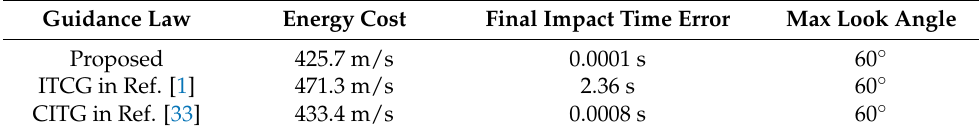
Table 6. Characteristics for T d = 35 s.